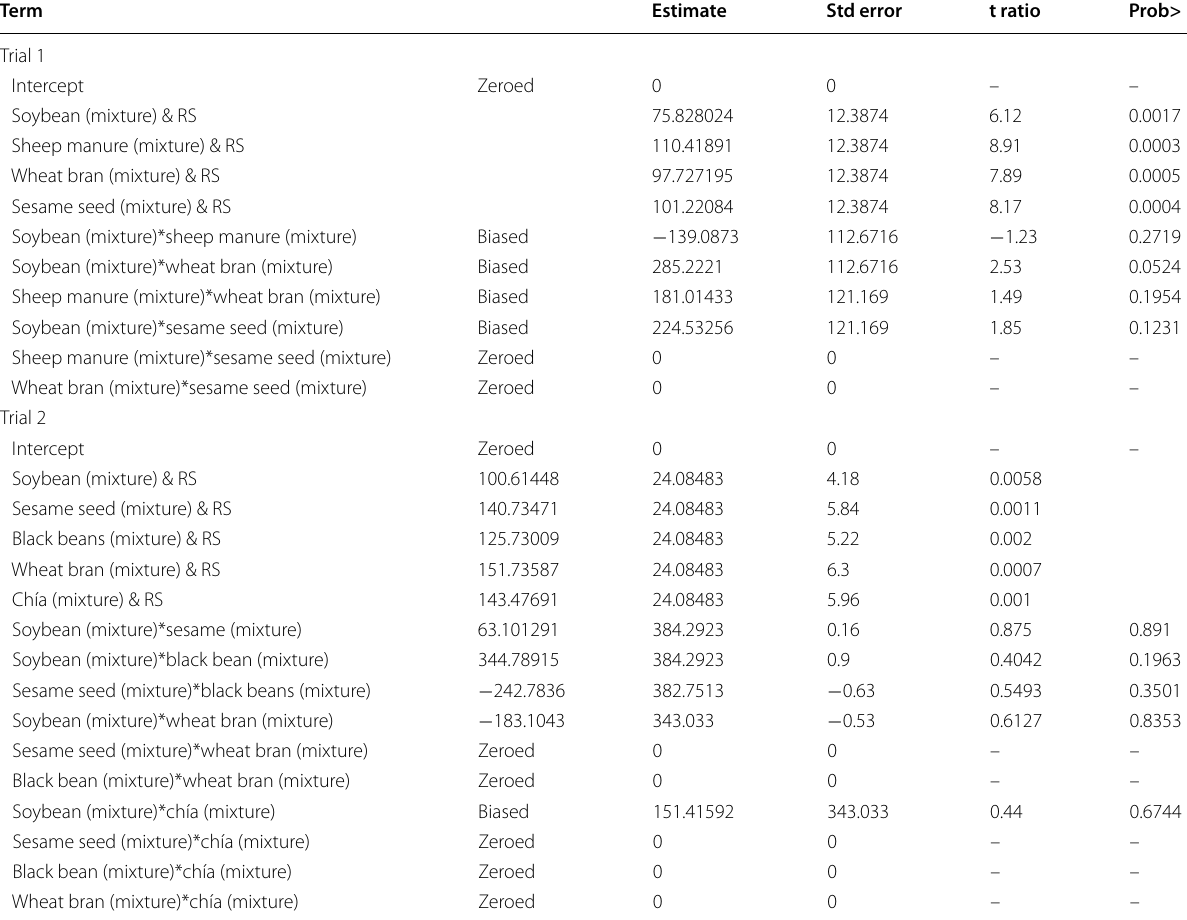
Table 7 Parameter estimates of the mixture design of two supplementation trials evaluated Term